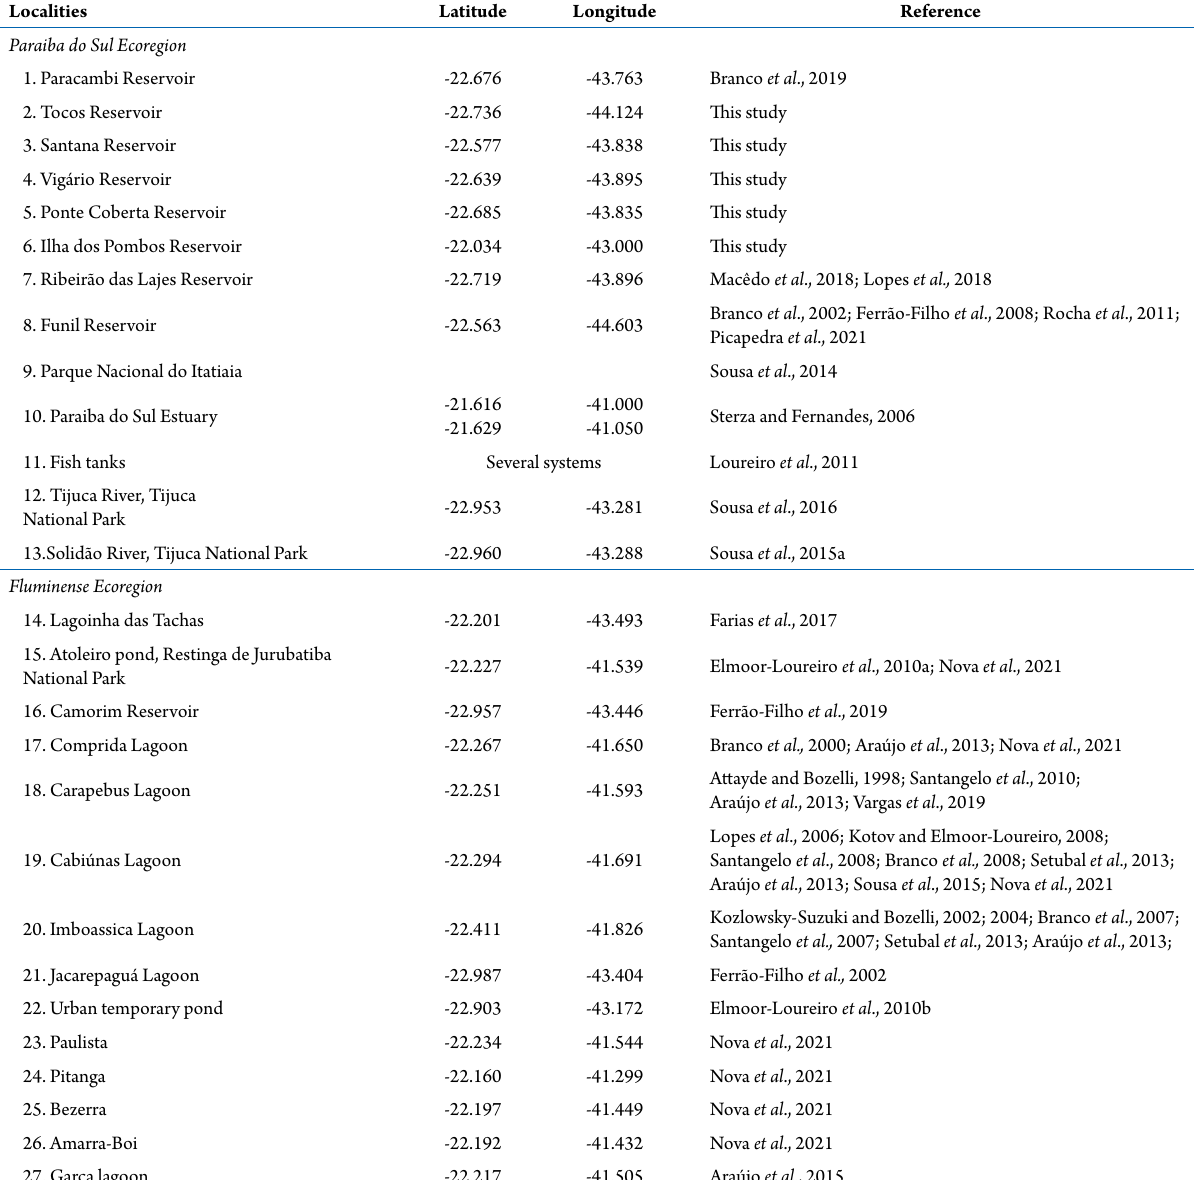
Table 1. Sampling localities with geographical coordinates of the records gathered from literature and from our surveys.